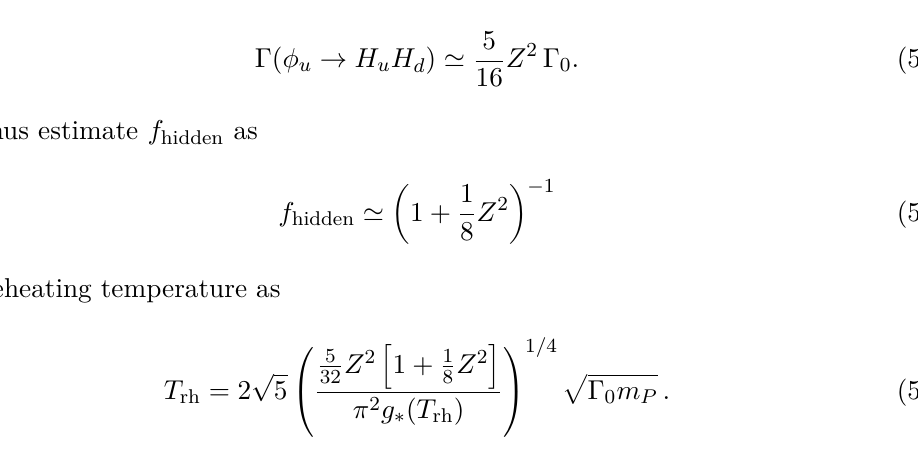
JHEP12(2022)068